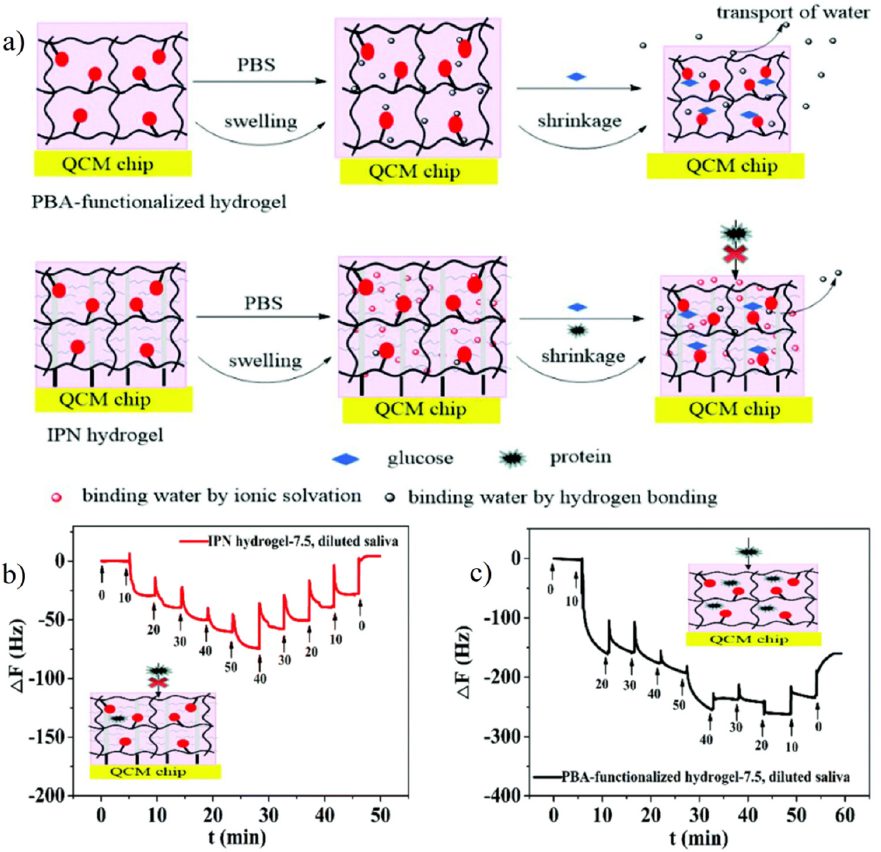
Figure 13. Zwitterionic interpenetrating network (IPN) hydrogel coating on QCM probe for highly sensitive glucose detection. ( a ) Schematic illustration of antifouling property of zwitterionic IPN hydrogel with glucose detection by PBA. ( b , c ) Glucose detection in 10% diluted saliva on zwitterionic IPN hydrogel coating QCM ( b ) and only PBA hydrogel coating QCM only ( c ). During the detection process with increased glucose concentration (10 to 50 mg/L), the frequency shift of IPN hydrogel coating QCM increased with the concentration increasing while those of PBA hydrogel coating QCM only showed a great increase in 10 mg/L. During the detection process with decreased glucose concentration, the only frequency shift of IPN hydrogel coating QCM also showed concentration correlation. These differences were caused by nonspecific protein adsorption in saliva. Reproduced with permission from [113]. Copyright 2020 The Royal Society of